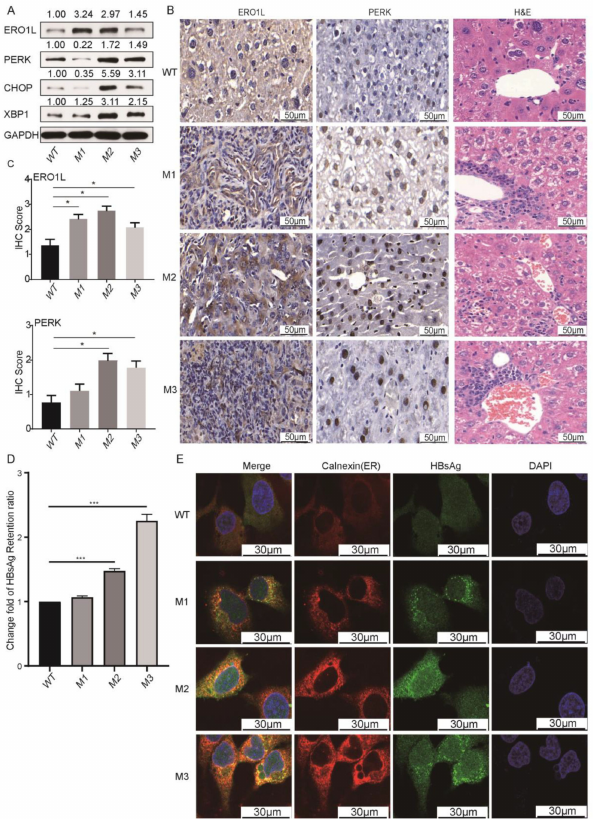
Figure 7. The preS1/preS2/S mutants significantly enhanced ER stress and the retention of HBsAg in ER. ( A ) The protein levels of ERO1L, PERK, CHOP, and XBP1 in Huh7 cells with ectopic expression of WT or preS1/preS2/S mutants. ( B ) Representative IHC and H&E images. Columns 1 and 2 show the IHC staining of EROL1 and PERK. In column 3, the ER stress-related pathological change, ground-glass hepatocytes, was more obvious in liver tissues from each group of preS1/preS2/S mutant-injected SB mice. ( C ) The histograms displaying the IHC scores of EROL1 and PERK in the liver tissues (vector group and WT group) and tumor tissues (groups of preS1/preS2/S mutants) from SB mice. ( D ) The change fold of intracellular HBsAg retention. The level of HBsAg in cells and medium was evaluated by ELISA. The HBsAg was presented by the ratio of intracellular HBsAg level to the HBsAg level in medium. The WT group was applied as reference to calculate change fold. ( E ) The result of immunofluorescence staining. Huh7 cells with the stable expression of WT, M1, M2, or M3 were immunostained with mouse anti-HBsAg (green) and rabbit anti-calnexin antibodies (red), with DAPI (blue) as nuclear counterstain. Co-localization of red and green immunofluorescence is visualized as yellow in merge images (first column) * p < 0.05, *** p <